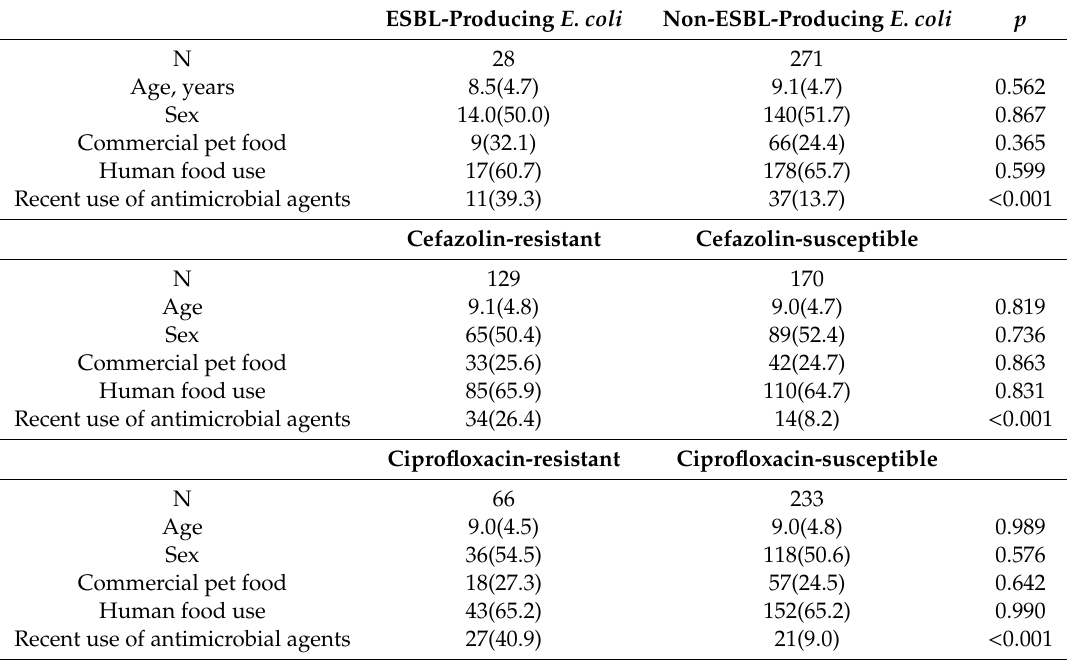
Table 2. Risk factors of E. coli fecal carriage of phylogenetic